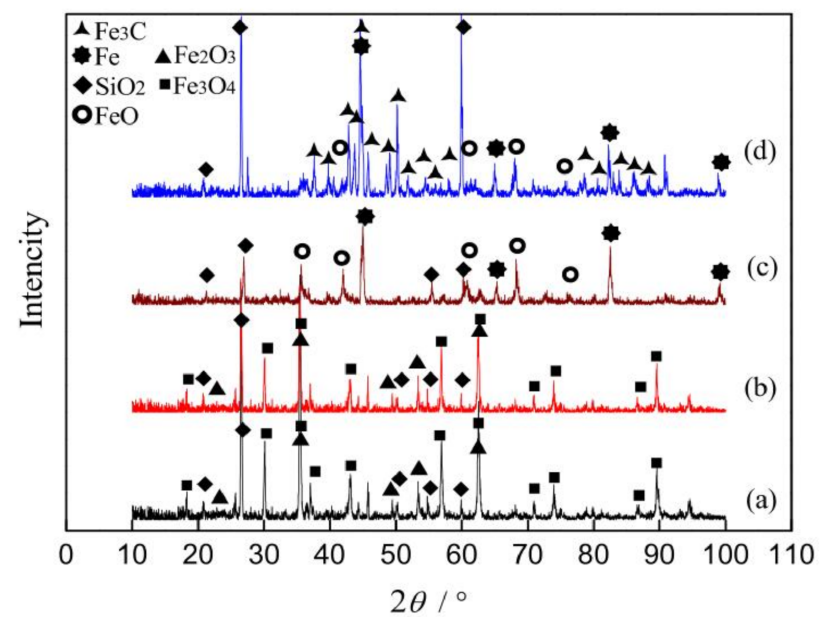
Figure 7. XRD analysis of original iron ore powder and sample coated with cow dung before and after reduction: ( a ) before the reduction of sample a; ( b ) before the reduction of coated 15% cow dung; ( c ) after the reduction loss of sample a; ( d ) after the reduction loss of 15% cow